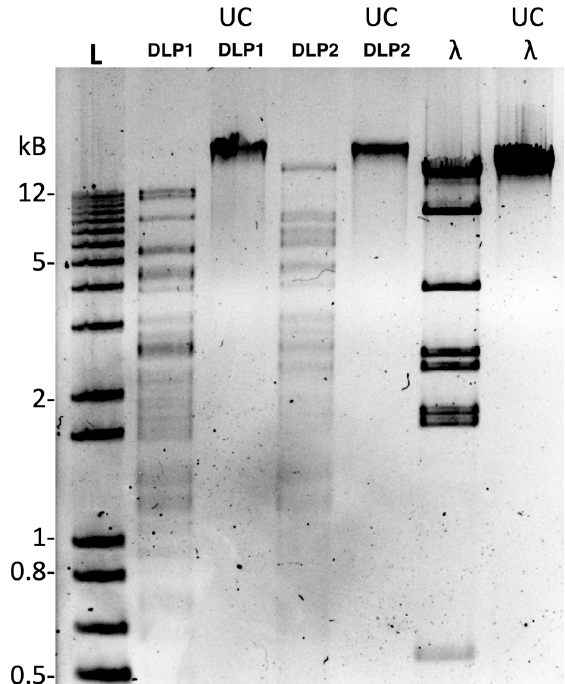
Figure 8. RFLP digestion of DLP1, DLP2, and λ control with Nde I. A total of 1 µg of phage gDNA